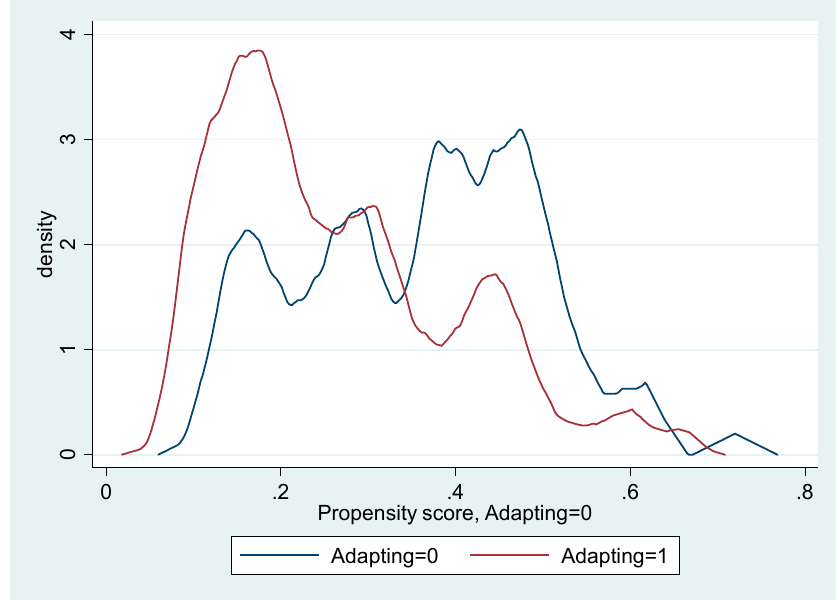
Figure 4. Distribution of propensity scores of adaptation response.